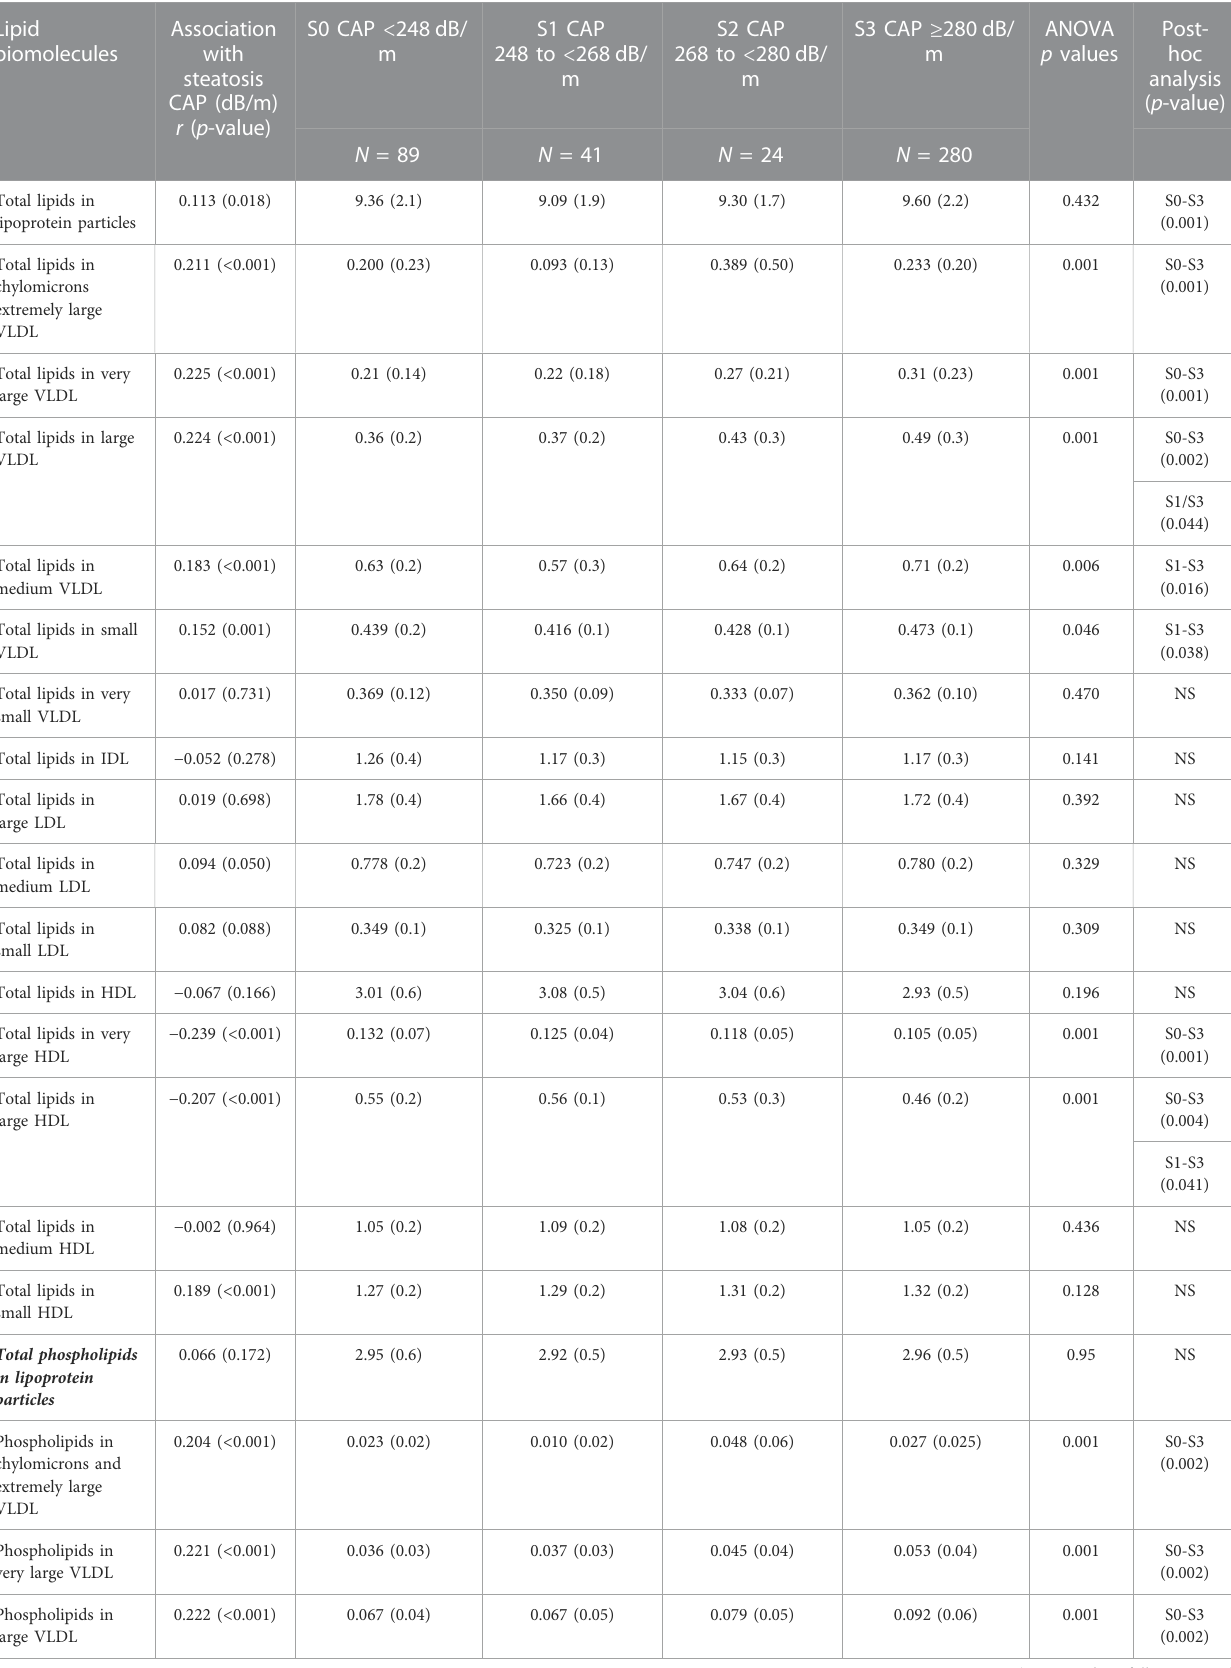
TABLE 1 Association of lipid biomolecules to steatosis, and lipid biomolecules according to steatosis grades in patients with